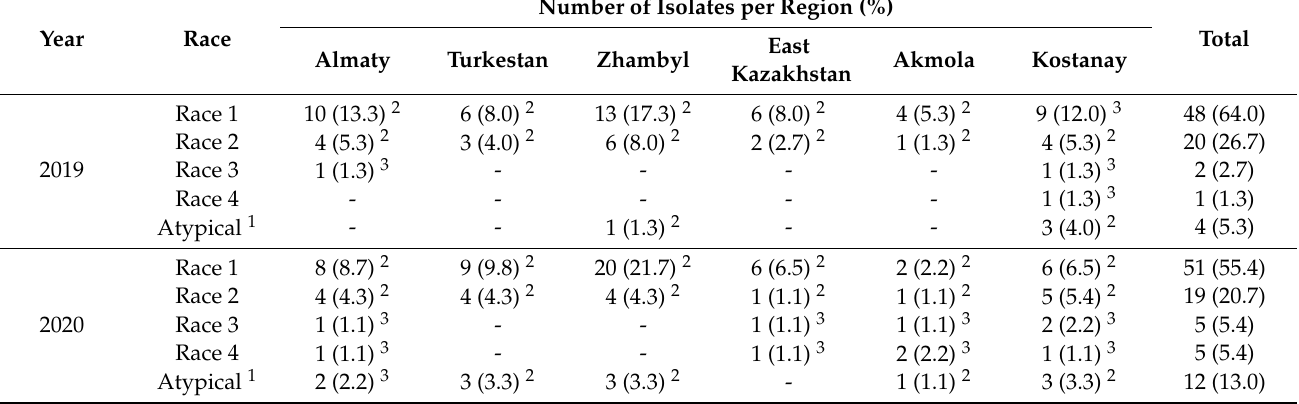
(Supplementary Table S1). No representatives of Races 3 and 4 were found in the Turkestan and Zhambyl regions. Table 3. Year, geographic origin, host, and race classification of Pyrenophora tritici-repentis isolates collected in Kazakhstan during 2019 and 2020.